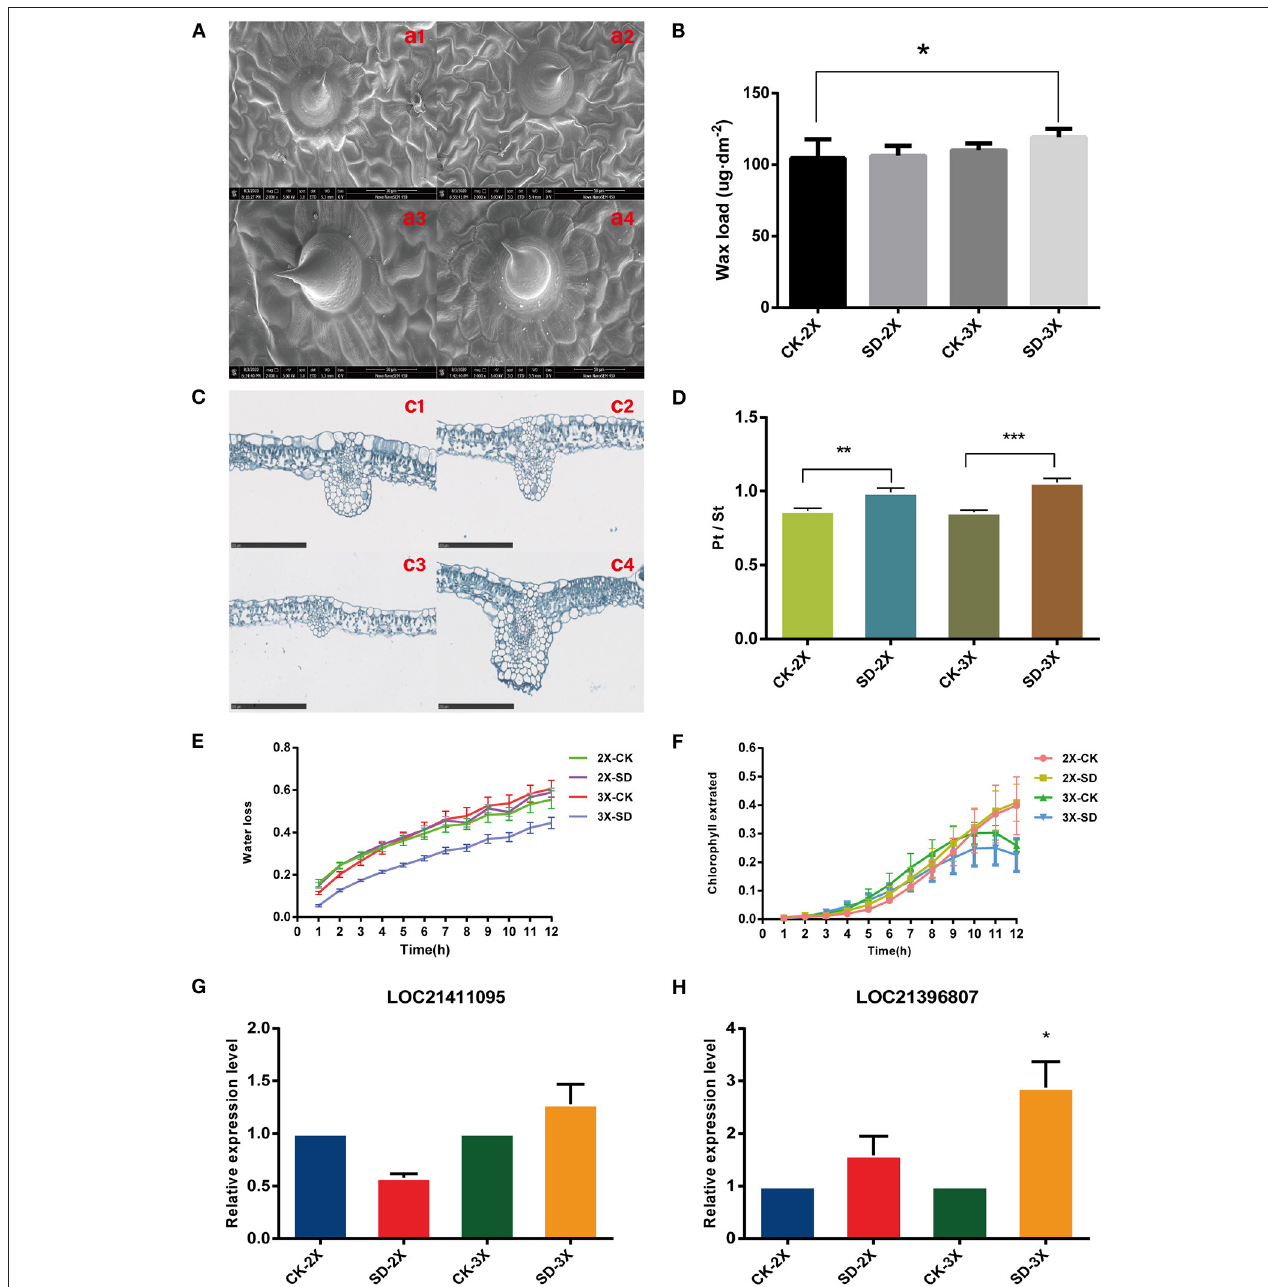
FIGURE 5 | Surface wax load, surface permeability, and histological traits of leaf in diploid (2X) and triploid (3X). (A) Morphological display of surface wax in the pressure side of leaf of diploid (2X) and triploid (3X) under two water treatments observed using scanning electron microscopy (SEM). Ample water treatment: (a1) CK-2X; (a3) CK-3X; Severe drought stress: (a2) SD-2X; (a4) SD-3X. (B) The wax coverage changes of leaf during water deprivation treatment for 9 days. (C) Histological characterization of leaves of diploid (2X) and triploid (3X) in well-watered and drought stress for 9 days. Ample water treatment: (c1) CK-2X; (c3) CK-3X; Severe drought stress: (c2) SD-2X; (c4) SD-3X. Bar = 250 um. (D) Palisade tissue-spongy tissue ratio of two cultivars. Surface permeability of leaves with drought stress. (E) Water loss rates and (F) chlorophyll extraction yields. Values represent means of three replicates. Error bars = SD. (G,H) Quantitative real-time PCR analysis of LOC21411095, LOC21396807 expression between diploid (2X) and triploid (3X) with drought stress, which related to wax synthesis. All assays were carried out at least three times and statistical significance levels were calculated using Student’s t -test (* P ≤ 0.05; ** p ≤ 0.01; *** p ≤ 0.001). CK, control; SD, severe